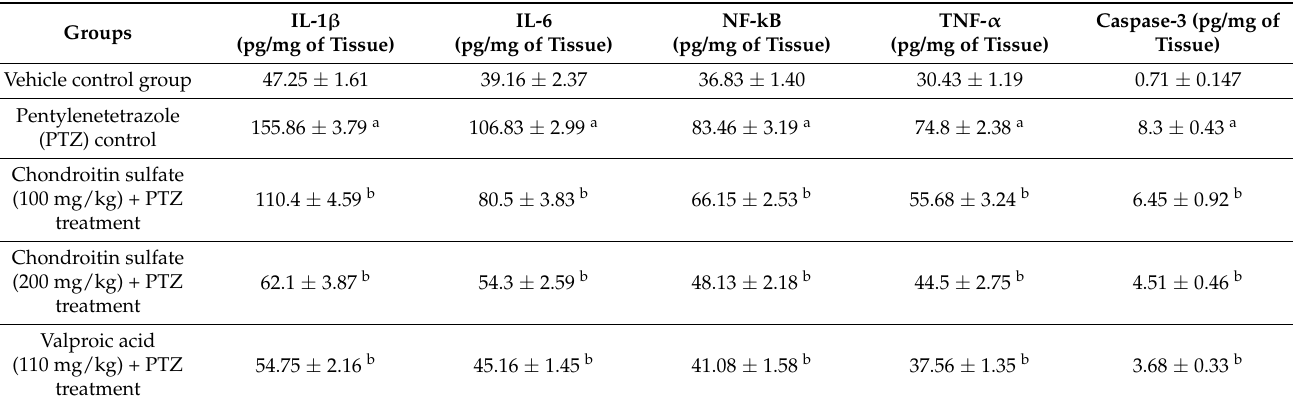
Table 3. Neuroprotective effect of chondroitin sulfate on IL-1 β , IL-6, NF-kB, and TNF- α concentration in PTZ-induced kindling seizures in mice. Values are expressed as mean ± S.D.; a p < 0.01 vs. vehicle control; b p < 0.05 vs. PTZ control.